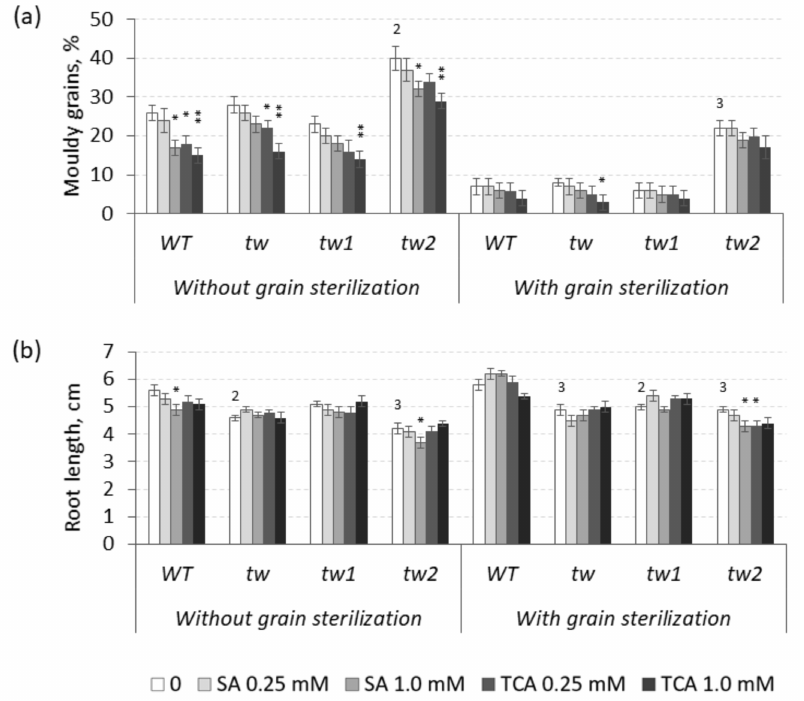
Figure 3. Effects of salicylic (SA) and trans -cinnamic (TCA) acids on ( a ) the frequency of mouldy grains (%) and ( b ) the root lengths (cm) of unsterilized and sterilized germinating grains of barley tw mutants and the WT , as measured after 5 days. For mouldy grains, n = 10 (100 grains); for root length, n = 30. Grain was produced in 2016, and the MGG test was performed in 2020. The asterisks represent significant differences (* p < 0.05; ** p < 0.01) between the control and the SA or TCA treatment. The numbers denote significant differences ( 2 p < 0.01; 3 p < 0.001) between the controls of the tw -type mutant and the WT